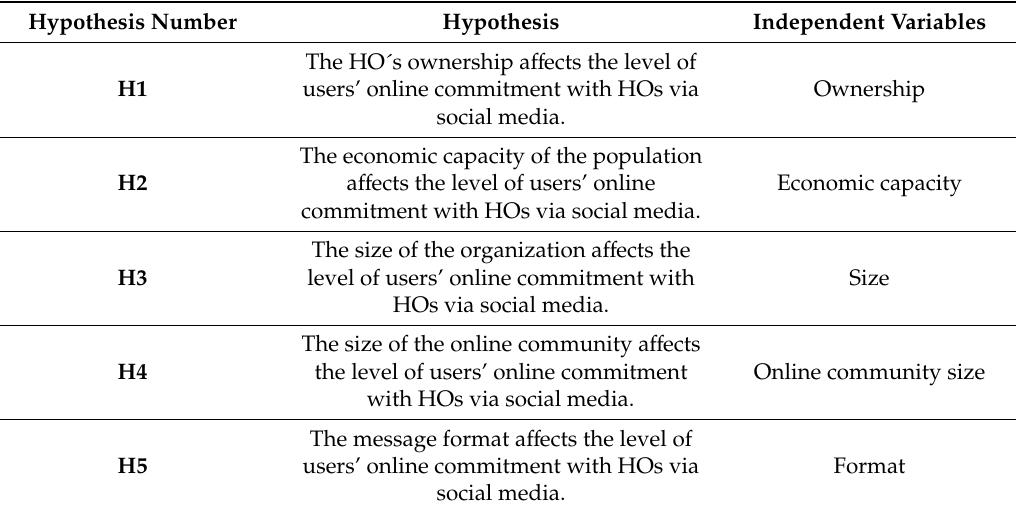
Table 1. Working hypotheses. HO: health